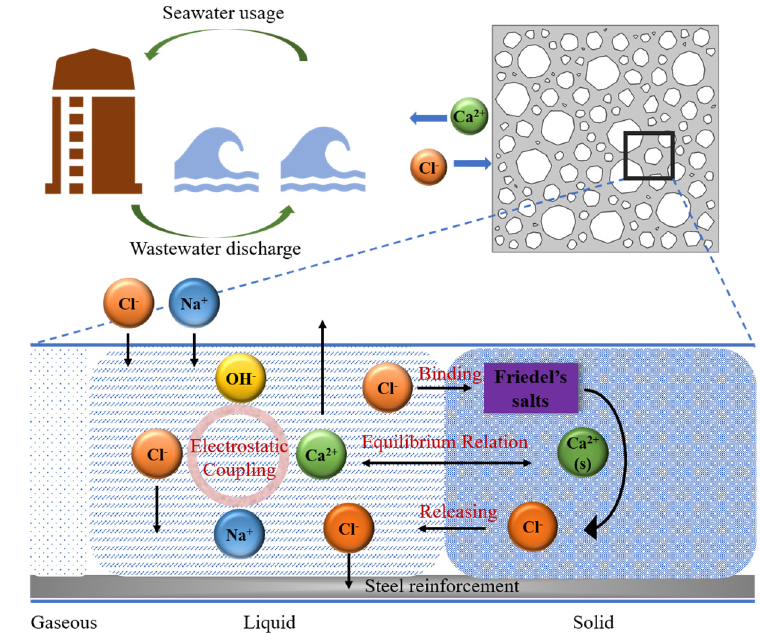
Figure 7. Schematic diagram of concrete suffering from both calcium leaching and chloride ingress. Adapted from